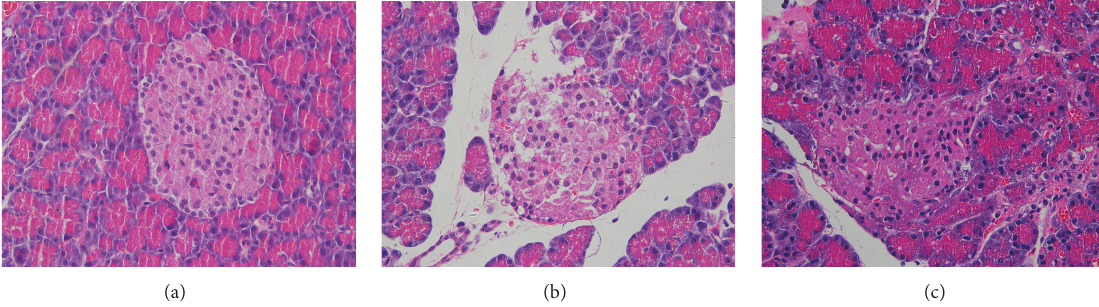
Figure 3: Morphologic changes in pancreatic islet at 12 hours in all groups of rats. Representative hematoxylin and eosin-stained sections were examined by light microscopy (original magnification, × 400). (a) SO group; (b) SAP group; (c) 4-PBA group.